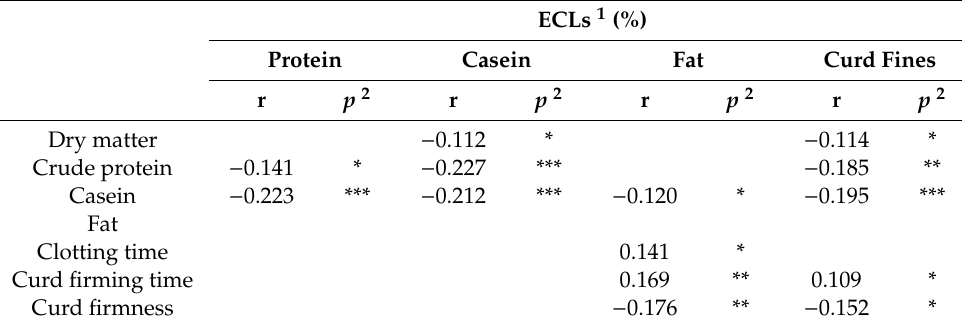
Table 2. Pearson product moment correlation coe ffi cient (r) between the milk characteristics and the estimated cheese-making loss (ECL) values and curd fines. Only significant correlations ( p < 0.05) are reported. ECLs 1 (%) Protein Casein Fat Curd Fines r p 2 r p 2 r − 0.112